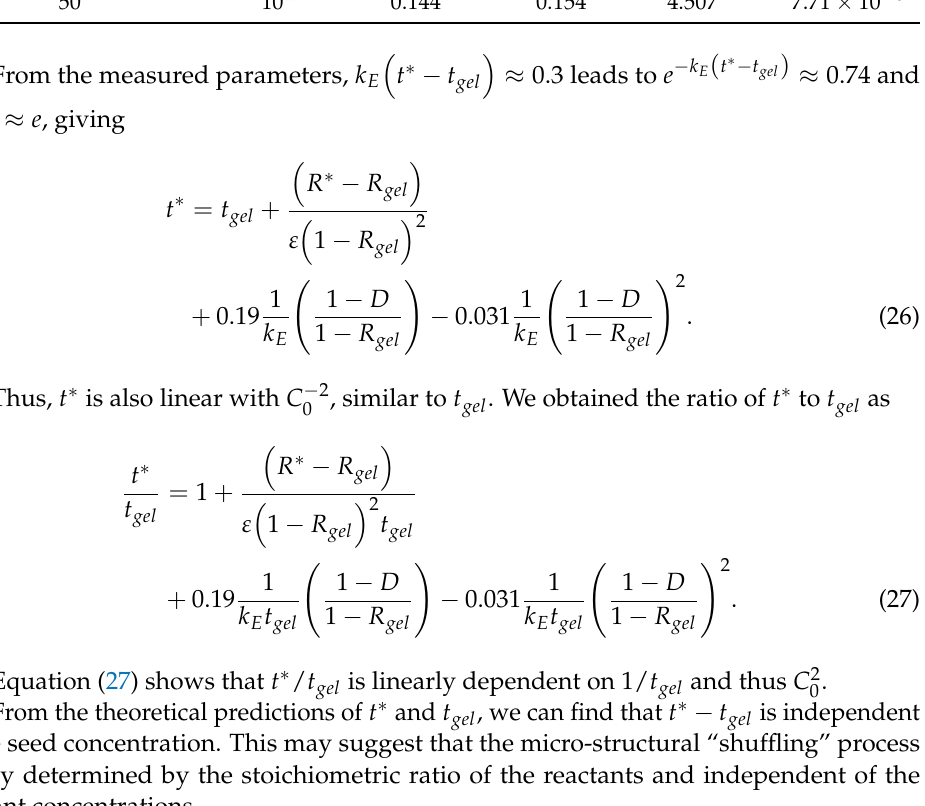
Table 2. Parameters for determining R and fitting experimental data in Figure 3. D [-]